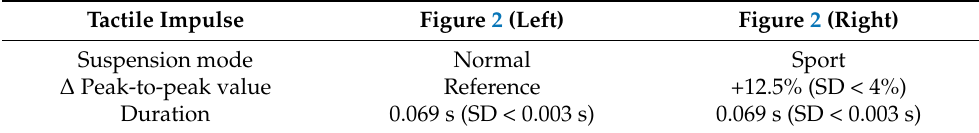
Figure 2. Representative vertical acceleration (filtered) at seat reference point in suspension mode normal ( Left ) and in suspension mode sport ( Right ) when driving over 30 mm falling edge with the rear wheels, visualized with Artemis Suite (HEAD acoustics). Table 1. Parameters of the tactile impulse.